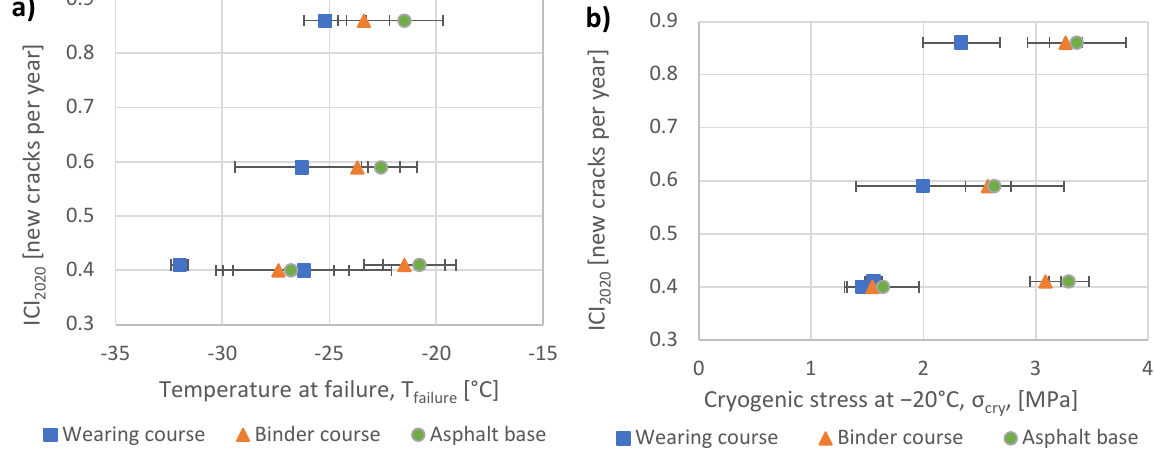
Figure 9. Relations between the increase in cracking index obtained for the period from the year of pavement construction up to 2020 (ICI 2020 ) and the results of the TSRST test. ( a ) Failure temperature; ( b ) Cryogenic stress at −20 °C.